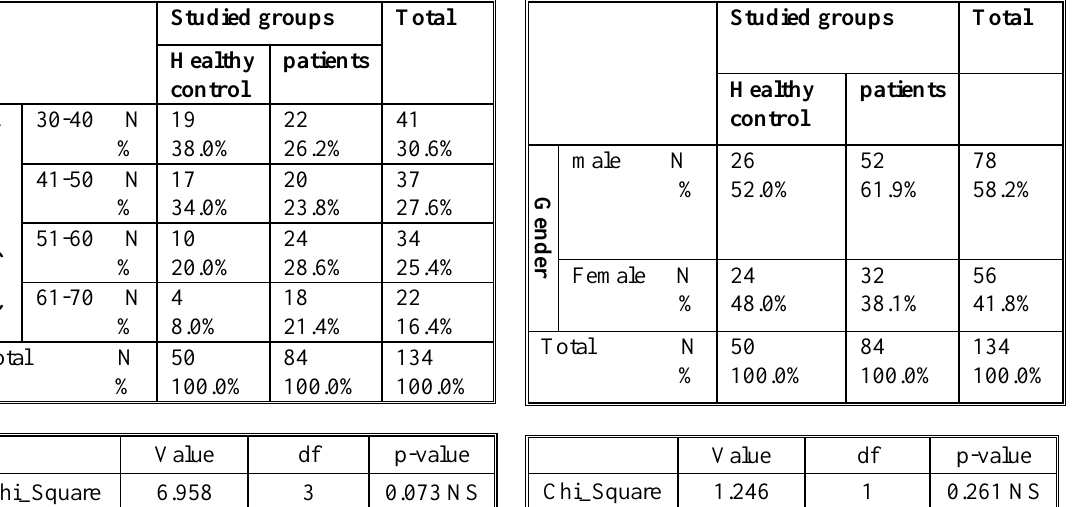
Table 2: Distribution of studied groups according to Gender.